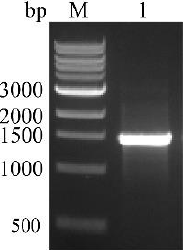
Figure 1. PCR result of 16S rDNA in WangLB bacterium. M: DNA marker. 1: PCR product. ilarity with that of Bacillus velezensis strain FZB42. Phylogenetic analysis results indicated that WangLB and two Bacillus velezensis bacteria shared the same clade (Figure 2), which suggested that WangLB bacterium belonged to Bacillus velezensis .